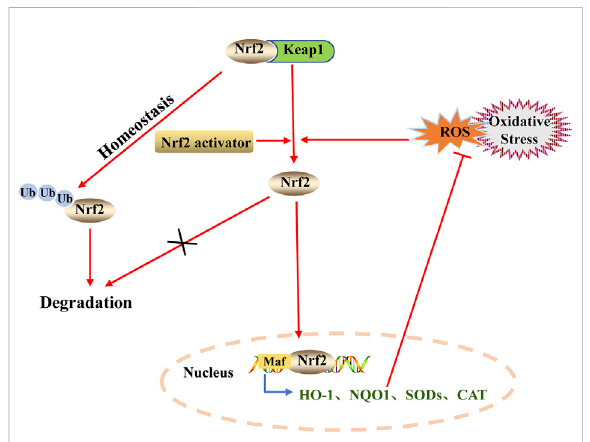
FIGURE 1 Regulation of Nrf2 degradation and activation. Under normal physiological conditions, Keap1 in the cytoplasm binds to Nrf2, which is ubiquitinated and degraded by the proteasome pathway. Underoxidativestress,theNrf2-Keap1complexisdissociated and Nrf2 istransferred to thenucleus. In the nucleus, Nrf2 binds to downstream antioxidant response elements (ARE) and activates the transcription of antioxidant